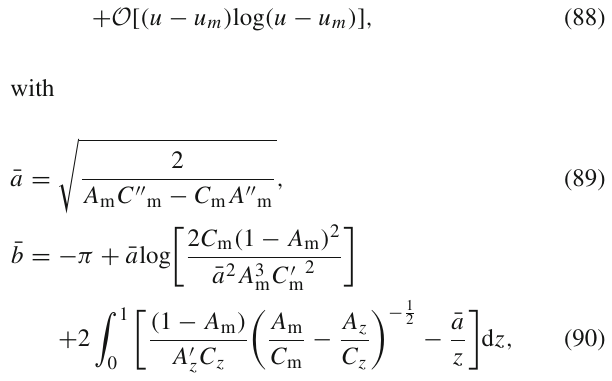
Reissner–Nordström spacetime (bbRN), the Reissner–Nordström black hole (RN), the tidal Reissner–Nordström black hole (TRN), the charged Horndeski black hole (CH) and the charged Galileon black hole